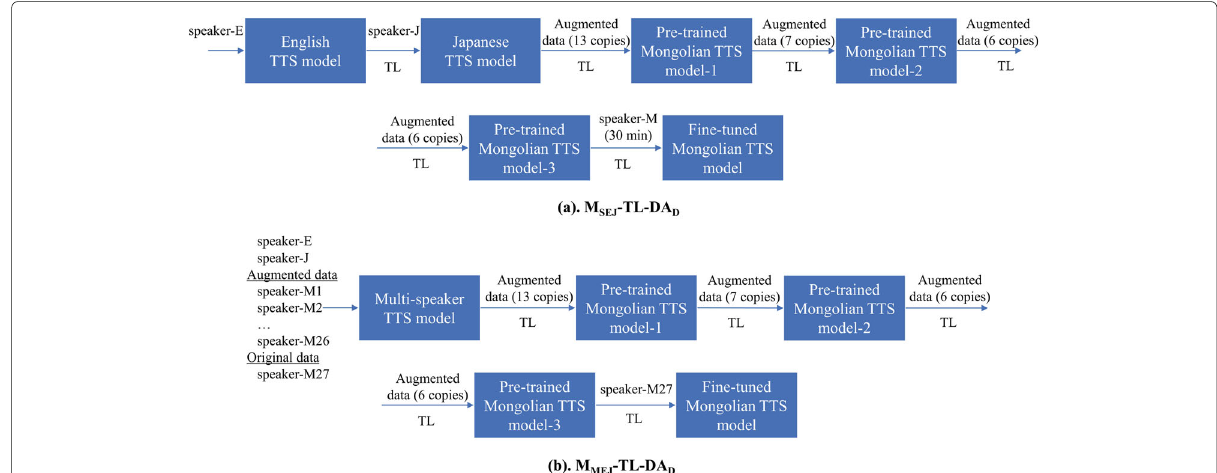
Fig. 9 Methods used to train TTS models using cross-lingual transfer learning and augmented data with additional fine-tuning steps, where a is a single speaker model and b is a multi-speaker model